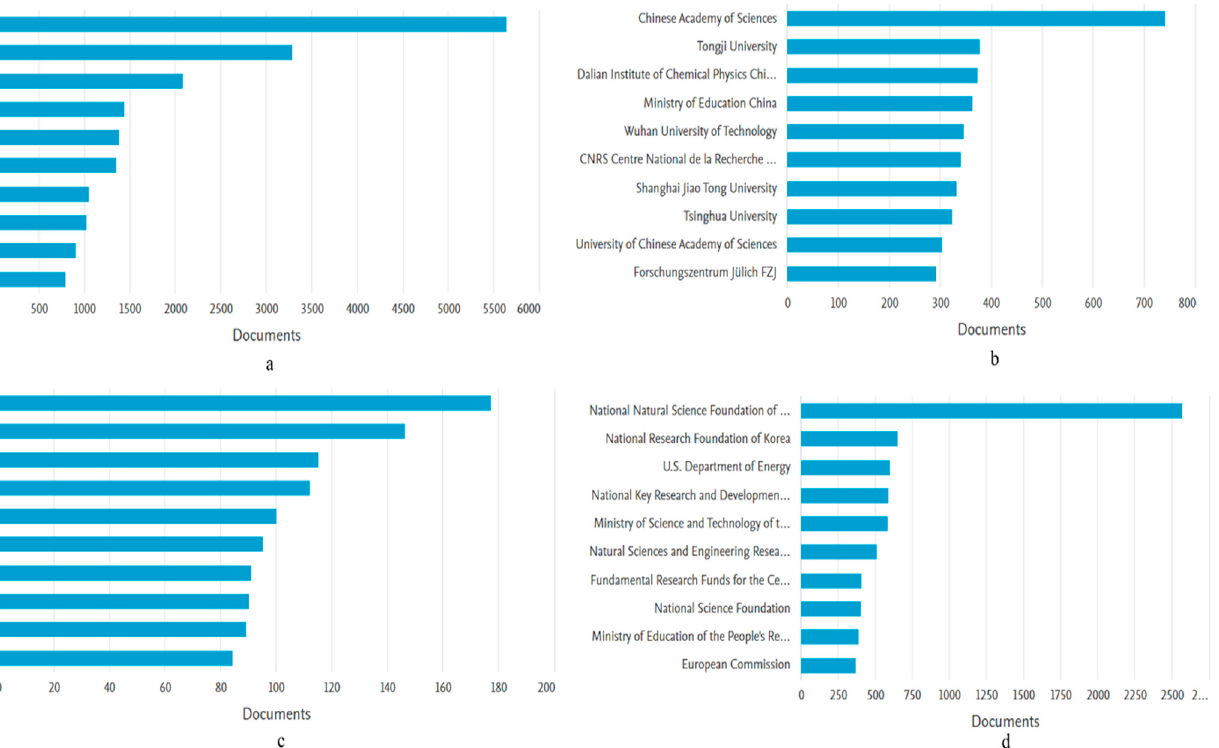
Figure 16. Top performing sources for PEMFC research from 2000 to 2021.